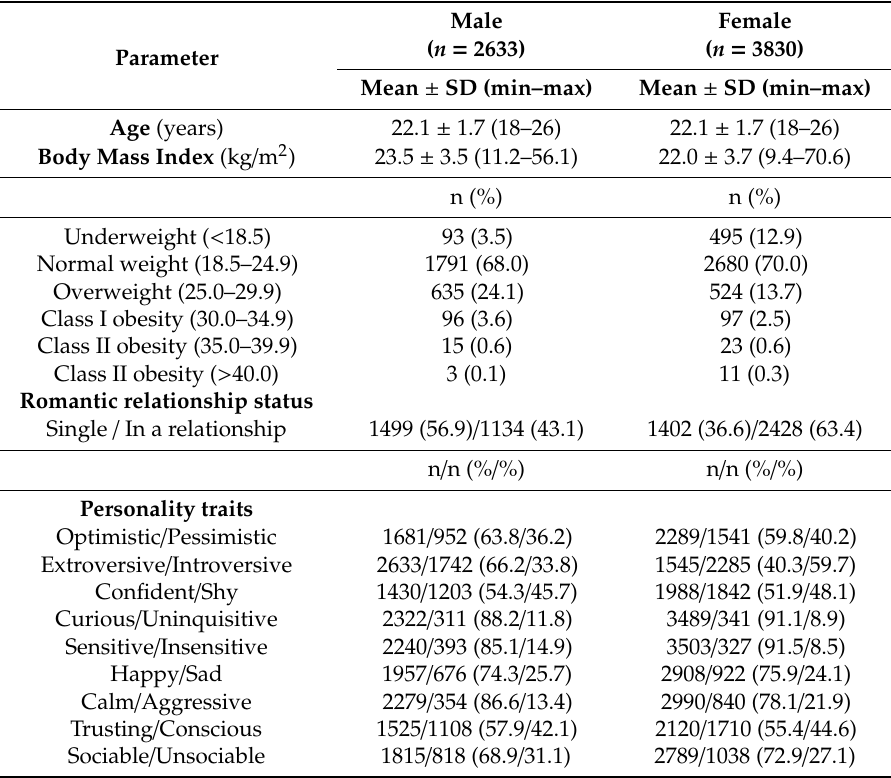
Table 1. Demographic characteristic of the studied group of university students ( n = 6463).